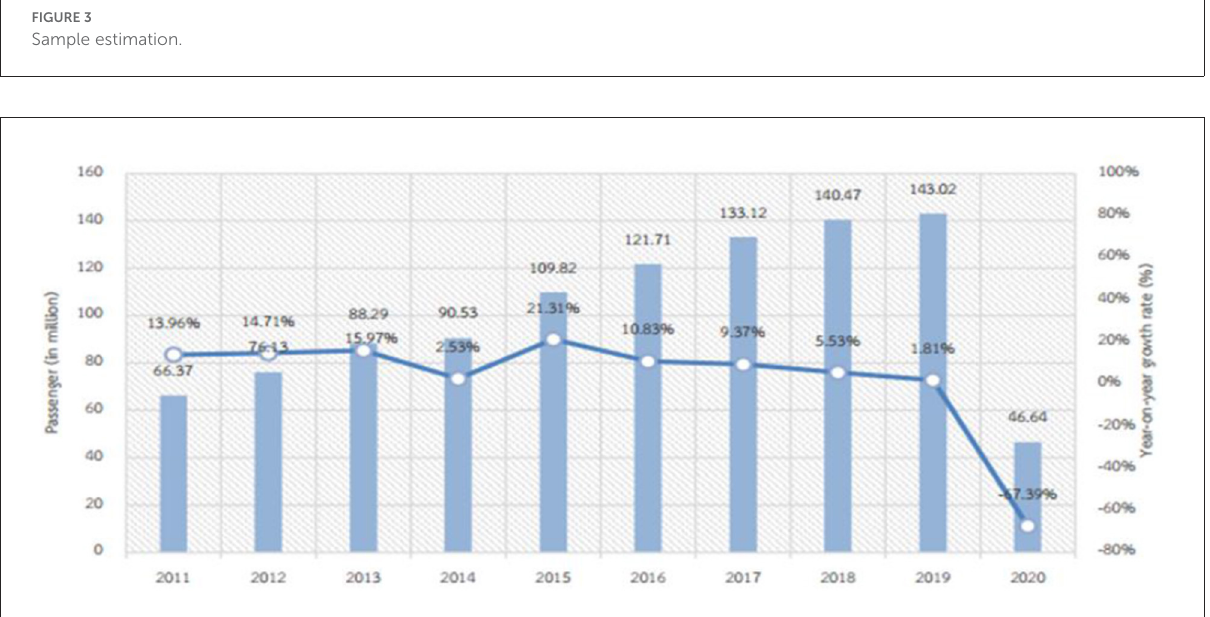
FIGURE4 Passengers (in millions) and % change